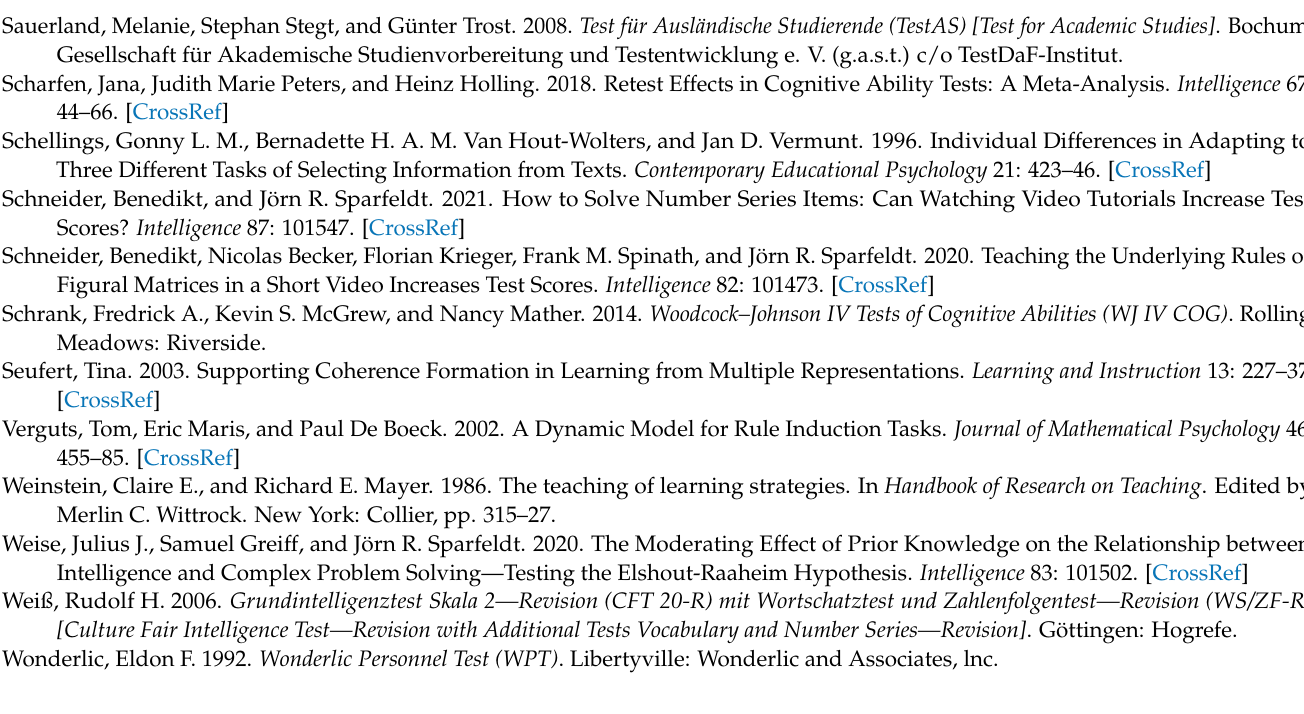
Figural Matrices in a Short Video Increases Test Scores. Intelligence 82: 101473. [CrossRef] Meadows: